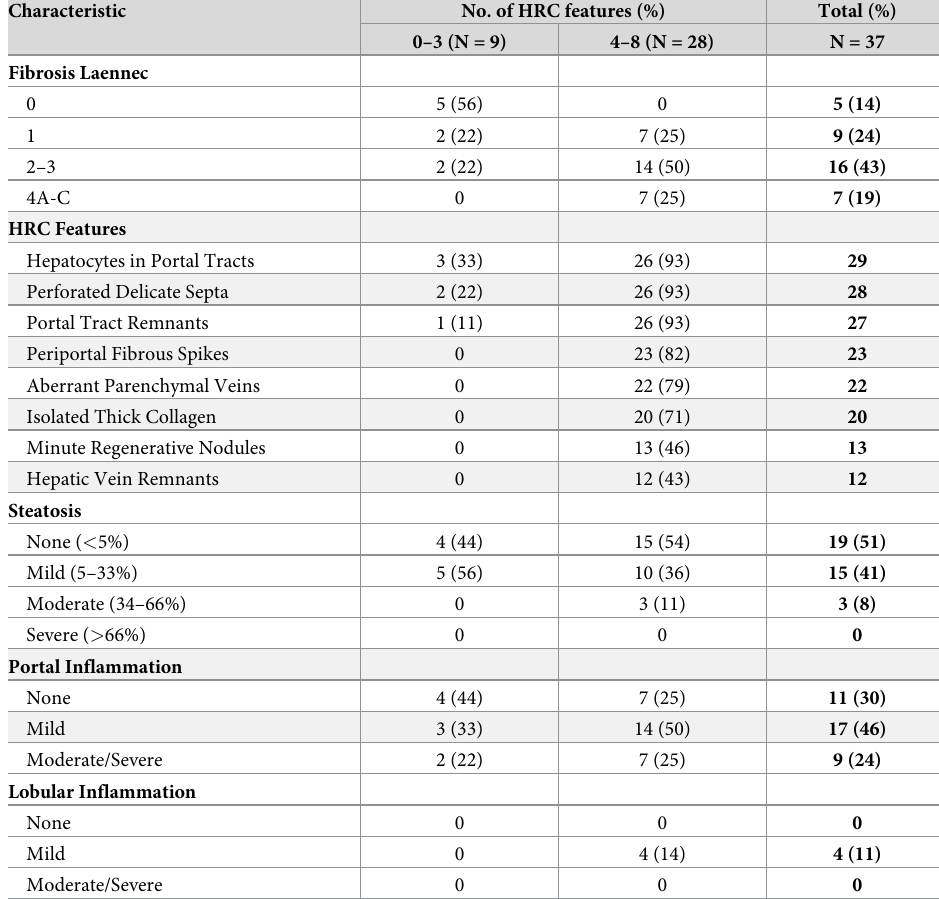
Table 2. Pathologic Features and Number of HRC